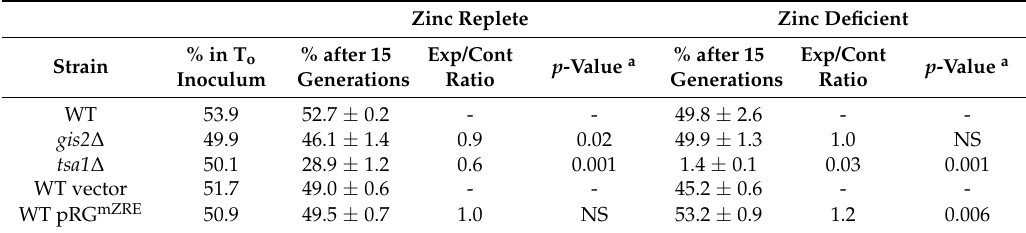
Figure 6. Proteomics analysis of cells with altered GIS2 expression. Mass spectrometry was used to analyze protein abundance in, ( A ) gis2 ∆ vs. wild-type zinc-replete cells (LZM + 100 µ M ZnCl 2 ) and ( B ) wild-type cells transformed with either the vector (pRS315) or pRG mZRE grown under zinc-deficient conditions (LZM + 6 µ M ZnCl 2 ). The volcano plots show the data plotted as − log ( q -value) vs. log2 fold change. Data are based on four biological replicates for each strain/growth condition. Statistically significant effects were defined as those proteins with 2-fold (log2 = 1) or greater changes and a q -value of < 0.05 after Benjamini-Hochberg correction. The full data from this analysis are provided in Table S1. Table 1. Effect of gis2 ∆ mutation and RTC4/GIS2 constitutive expression on cell